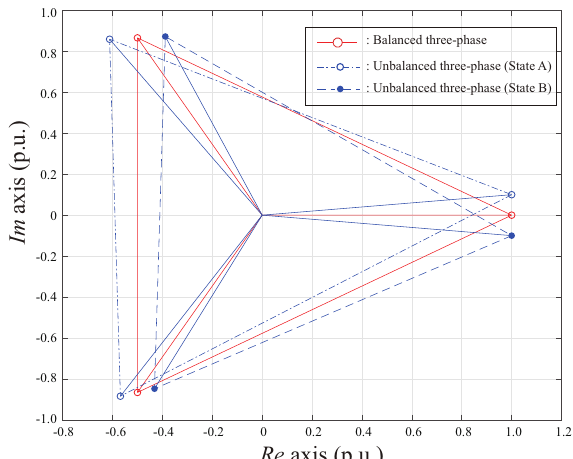
Figure 1. A representation of voltage unbalance by complex